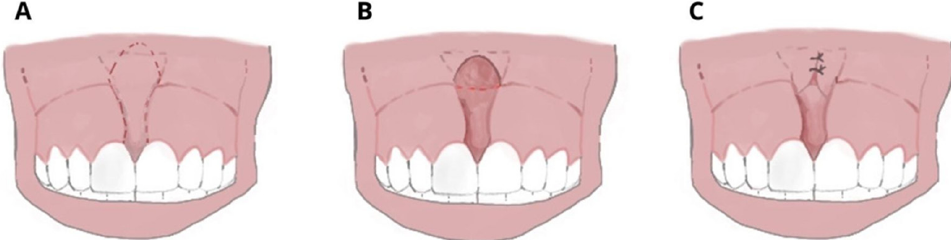
Figure 3. Frenectomy with traditional and V-shaped surgery: ( A ) Transpapillary frenulum; ( B ) two paramedian vertical incisions are drawn parallel to the sides of the frenulum up to the retroincisive papilla, where they connect with a horizontal cut; the frenulum is raised and the periosteum is exposed; ( C ) the margins are sutured along the midline, not involving the adherent gingiva; and periodontal wrap and healing by second